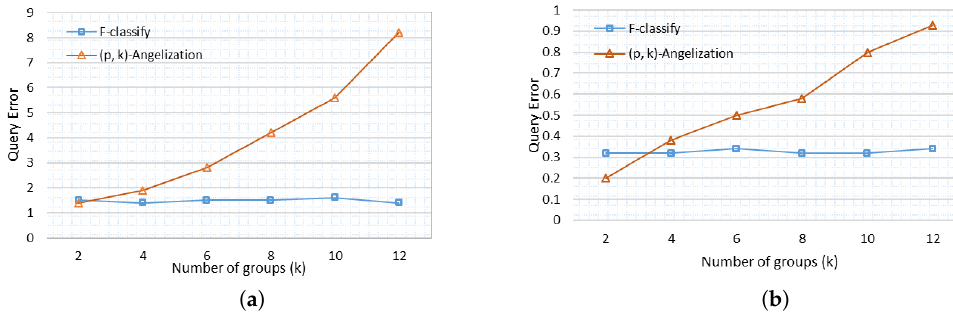
Figure 6. Relative Query Error (RQE) ( a ) RQE for Heart Disease ( b ) RQE for Adults.